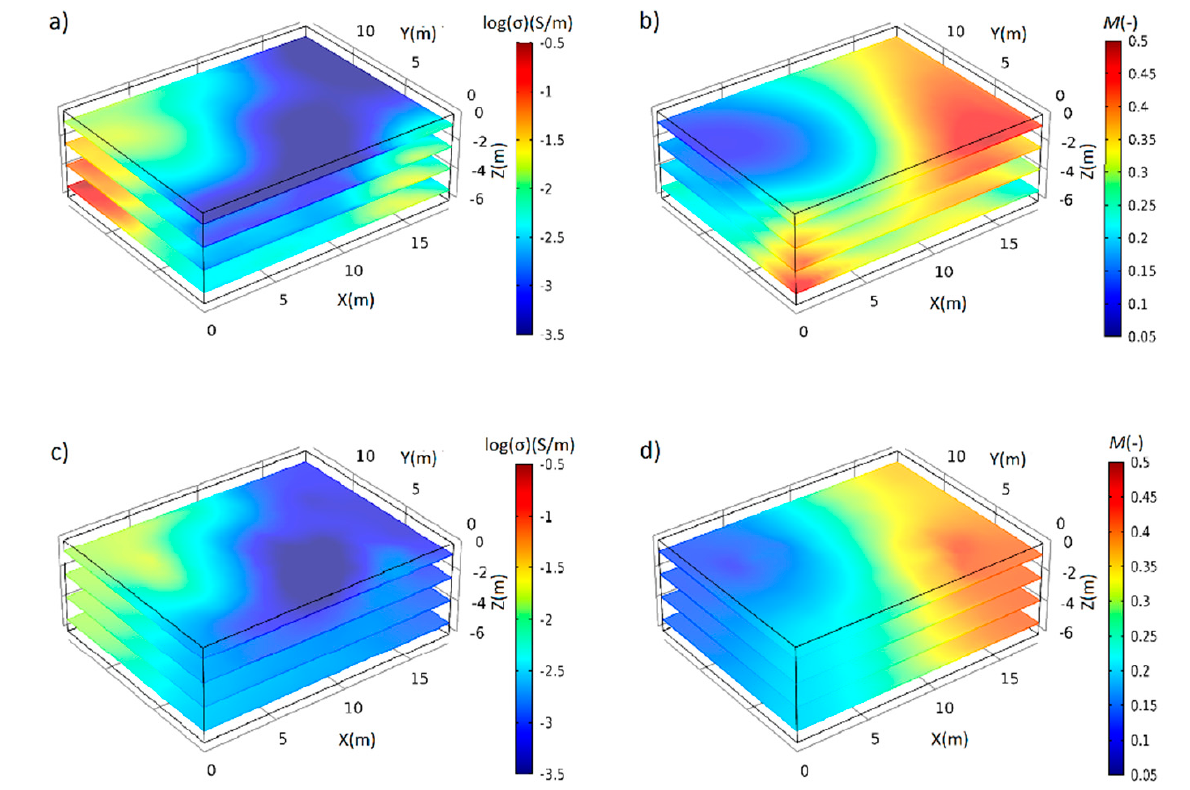
Figure 19. Deterministic induced polarization tomography test using a synthetic model. The sim- ulation domain covers a volume of 18 m × 14 m × 6 m. A total of 6 profiles are used at the top of this volume to simulate a survey (15 electrodes separated by 1 m from each other along a profile, and 2 m between profiles). We use a dipole–dipole configuration (372 apparent resistivity data and 372 apparent chargeability data, and 5% white noise added to the data). ( a ) True conductivity distribution. ( b ) True chargeability distribution. ( c ) Inverted conductivity distribution. ( d ) Inverted chargeability distribution. Modified from [98].